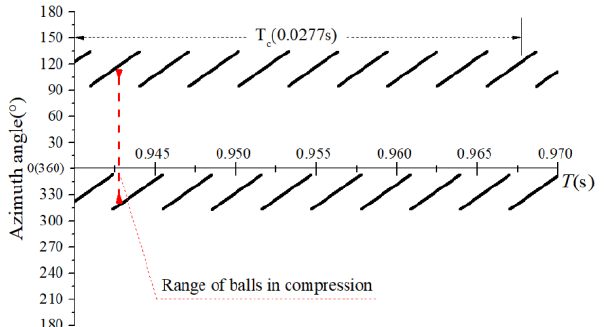
Figure 22. Time-domain diagram of the heavy load case load region.